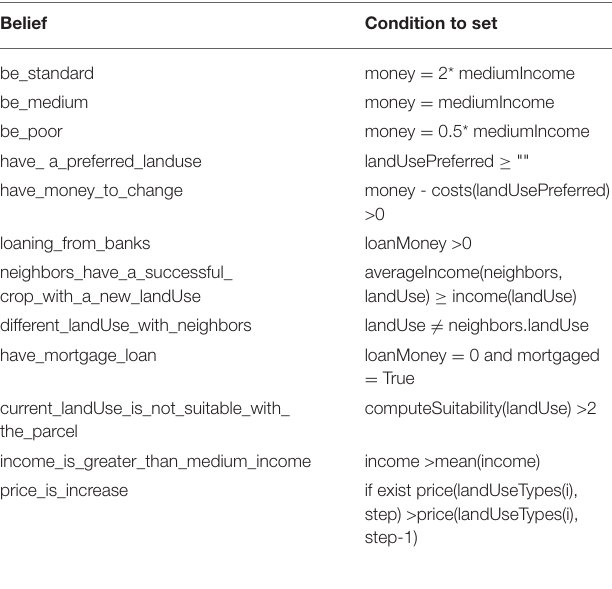
TABLE 2 | Relationships between the Beliefs, Desires and Intentions of farmers. Beliefs Desires and corresponding intentions